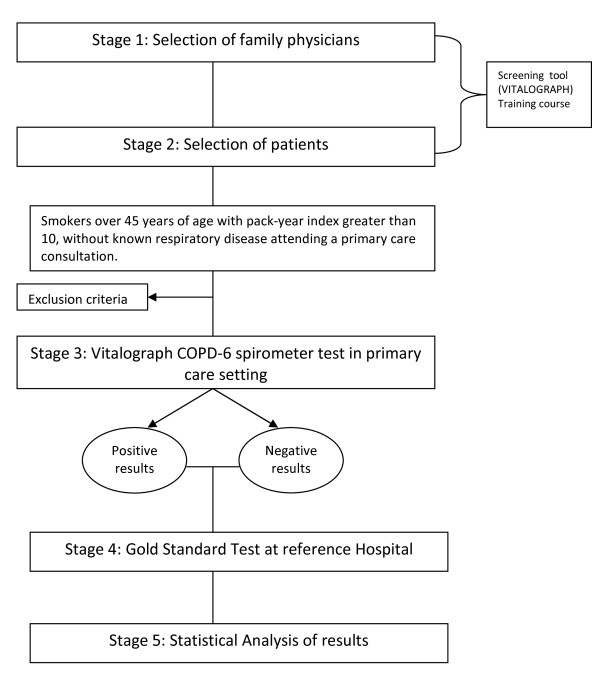
Flow diagram of the FUMEPOC study.